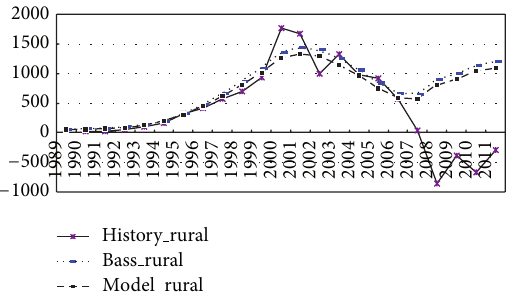
Figure 13: Plots of the diffusion rate of telephone in rural area by model (69) or model (70).